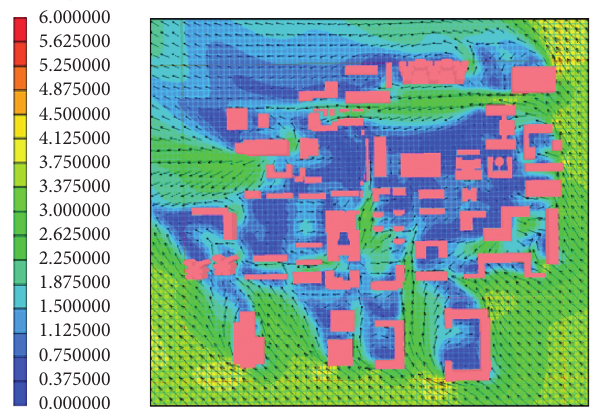
Figure 13: The wind velocity vector illustration at Z � 1.5m in summer.